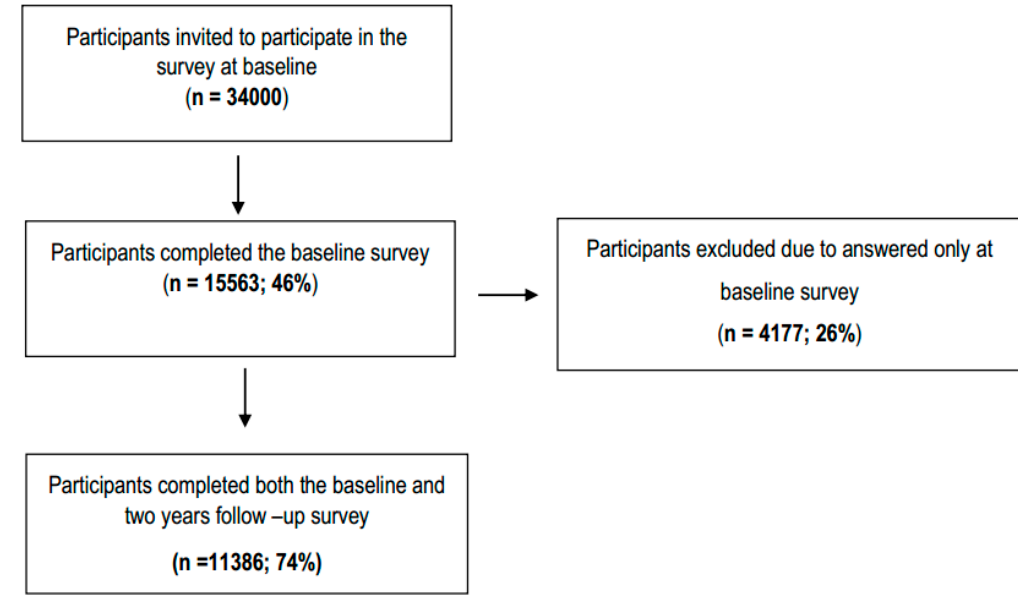
Figure 1. Flow chart outline the inclusion of participants for this study.